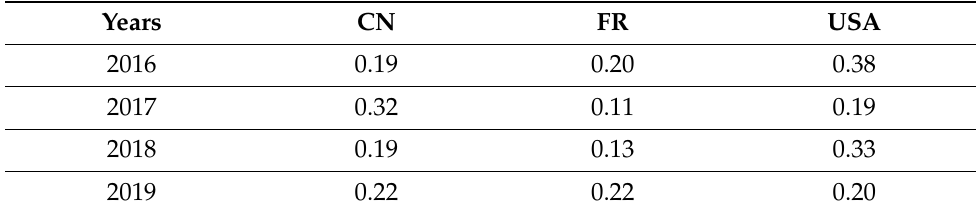
Table 1. Investment